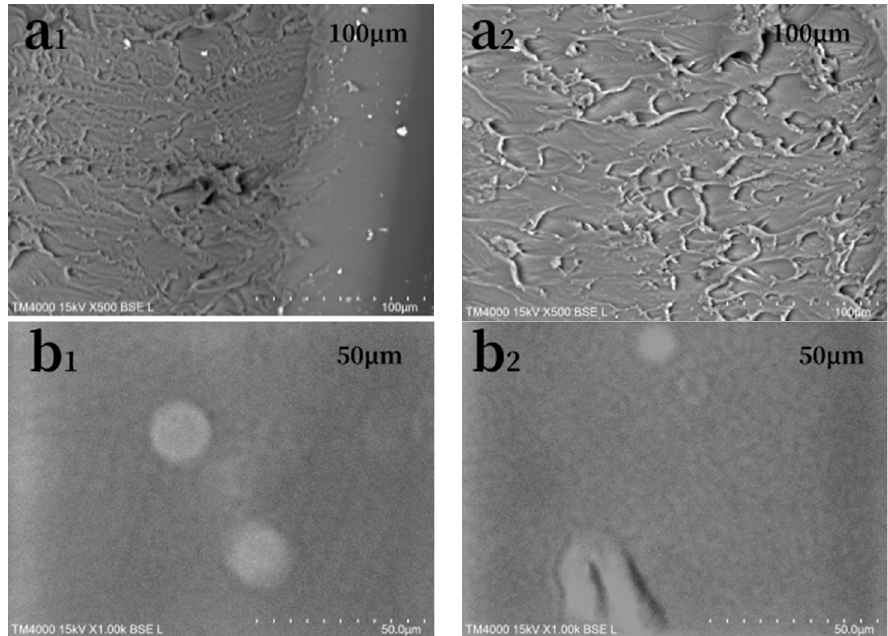
Figure 4. TM4000 images of WPU longitudinal section ( a 1 ), WPU surface ( b 1 ), SWPUA longitudinal section ( a 2 ), SWPUA surface ( b 2 ).